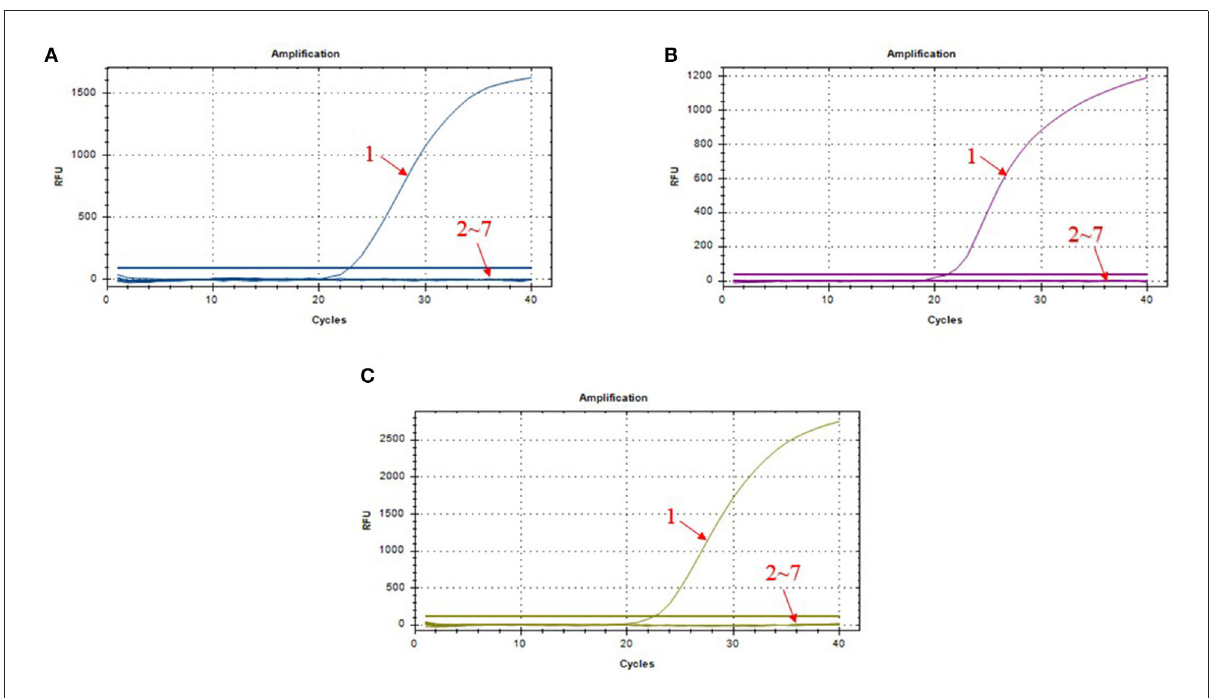
FIGURE3 Amplification curves in the specificity test of triplex real-time PCR assay. (A) amplification curves of B646L; (B) amplification curves of MGF_360-14L; (C) amplification curves of CD2v; 1: ASFV; 2–7: PRV, PRRSV, JEV, PPV, PCV2, and DNA-free